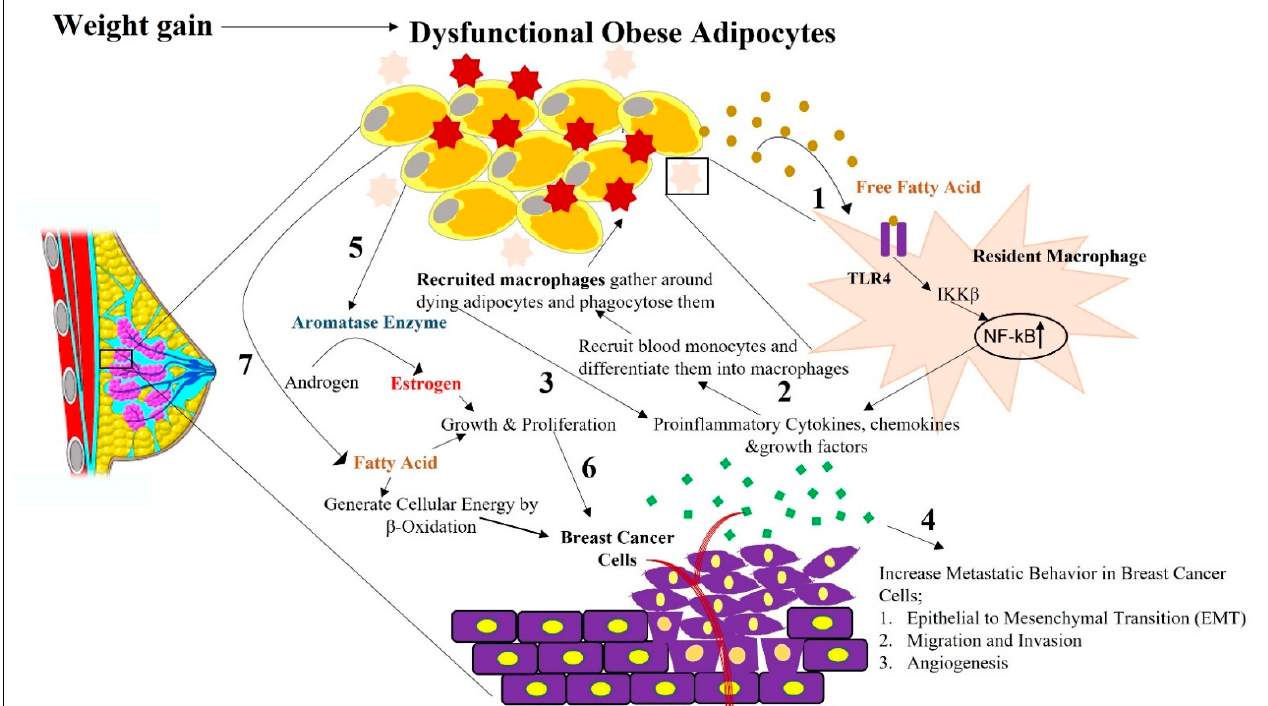
Figure 1. Schematic representation depicting how obesity-associated changes in white adipocytes adjacent to breast cells in the tumor microenvironment can impact breast cancer initiation and its progression. Impaired physiological function of white adipocytes due to increased fat accumulation, followed by hypoxia and ECM stiffness, causes them to undergo apoptosis-induced cell death. 1. During this cell death phase, cellular contents are released from dying adipocytes. These released contents, such as free fatty acids, cause receptor-mediated activation of TLR4 in resident macro- phages. This activation of TLR4 stimulates the secretion of proinflammatory cytokines, chemokines, and growth factors from the resident macrophages via NF-kB activation. 2. From the released chem- okines, CCL2 facilitates the recruitment of blood monocytes around the dying adipocytes from the surrounding intravascular spaces. In the presence of environmental cues in the breast tumor micro- environment, these monocytes differentiate into macrophages, which are then considered recruited macrophages. 3. There is further increased intracellular signaling in macrophages via NF-kb-, STAT3-, and JNK-related pathways, followed by the release of proinflammatory cytokines, creating a state of chronic inflammation. 4. Increased secretion of proinflammatory cytokines and hormones from white adipocytes, further facilitates the metastatic progression of breast cancer via their para- crine influence on proximal breast cells. 5. Obesity-associated increased release of proinflammatory cytokines further increases the expression of aromatase in white adipocytes, which then converts androgens to estrogens in adipose tissues. 6. This promotes mammary tumorigenesis by increasing the growth and proliferation of breast cancer cells. 7. Obese adipocyte-released free fatty acids shunt breast cancer cells towards β -oxidation as a source of energy to sustain breast cancer progression.